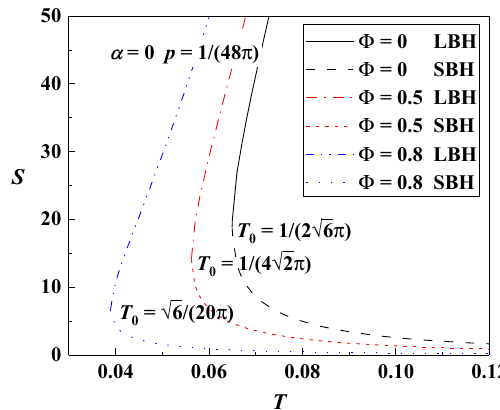
Fig. 8 The Gibbs free energy of the RN–AdS black holes as a function Fig. 7 Theentropies oflargeandsmallRN–AdS blackholesasafunc- of temperature, with a fixed pressure p = 1 /( 48 π) and different values tion of temperature, with a fixed pressure p = 1 /( 48 π) and different of Φ . T HP decreases with Φ , and the RN–AdS blackholes have minimal values of Φ . Similar to the Schwarzschild–AdS black holes with the √ temperatures T minimal temperatures T 0 = 2 p /π , the RN–AdS black hole temper- (cid:6) ature also has its minimum T 0 = 2 p ( 1 − Φ 2 )/π , corrected by the electric potential